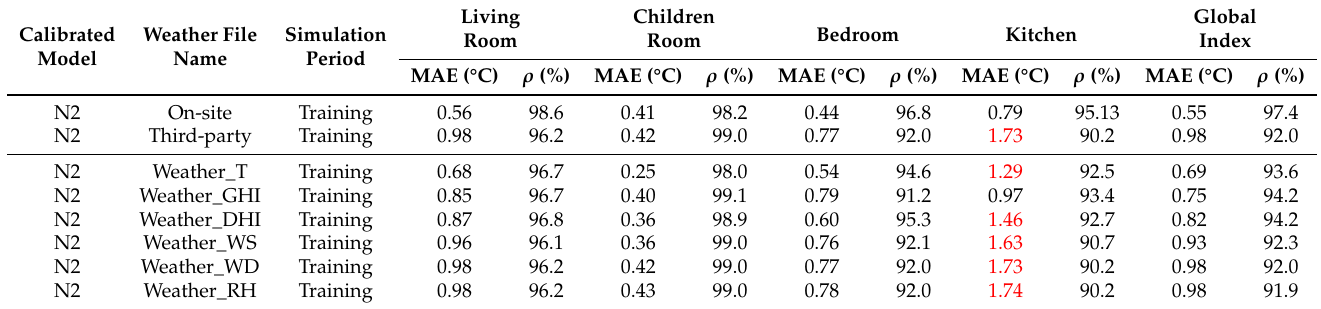
Table A3. MAE and ρ indices per thermal zone in the training period. House N2, calibrated model.